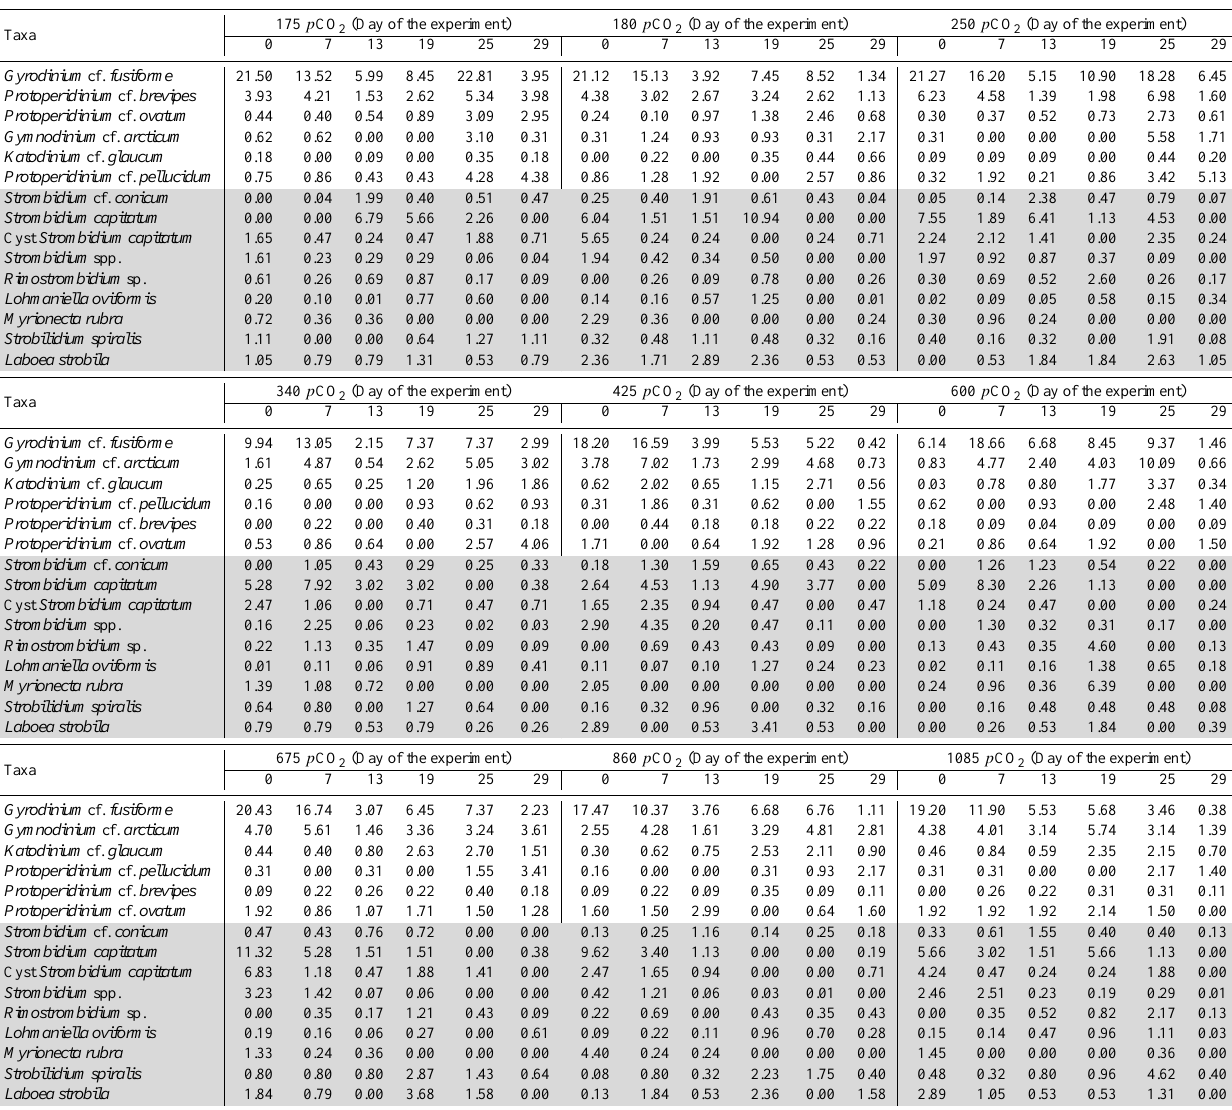
Table 2. Taxonomic composition of microzooplankton (biomass in µgCL − 1 ) over the course of the mesocosm experiment (white rows: dinoflagellates; light grey rows: ciliates) in the different p CO 2